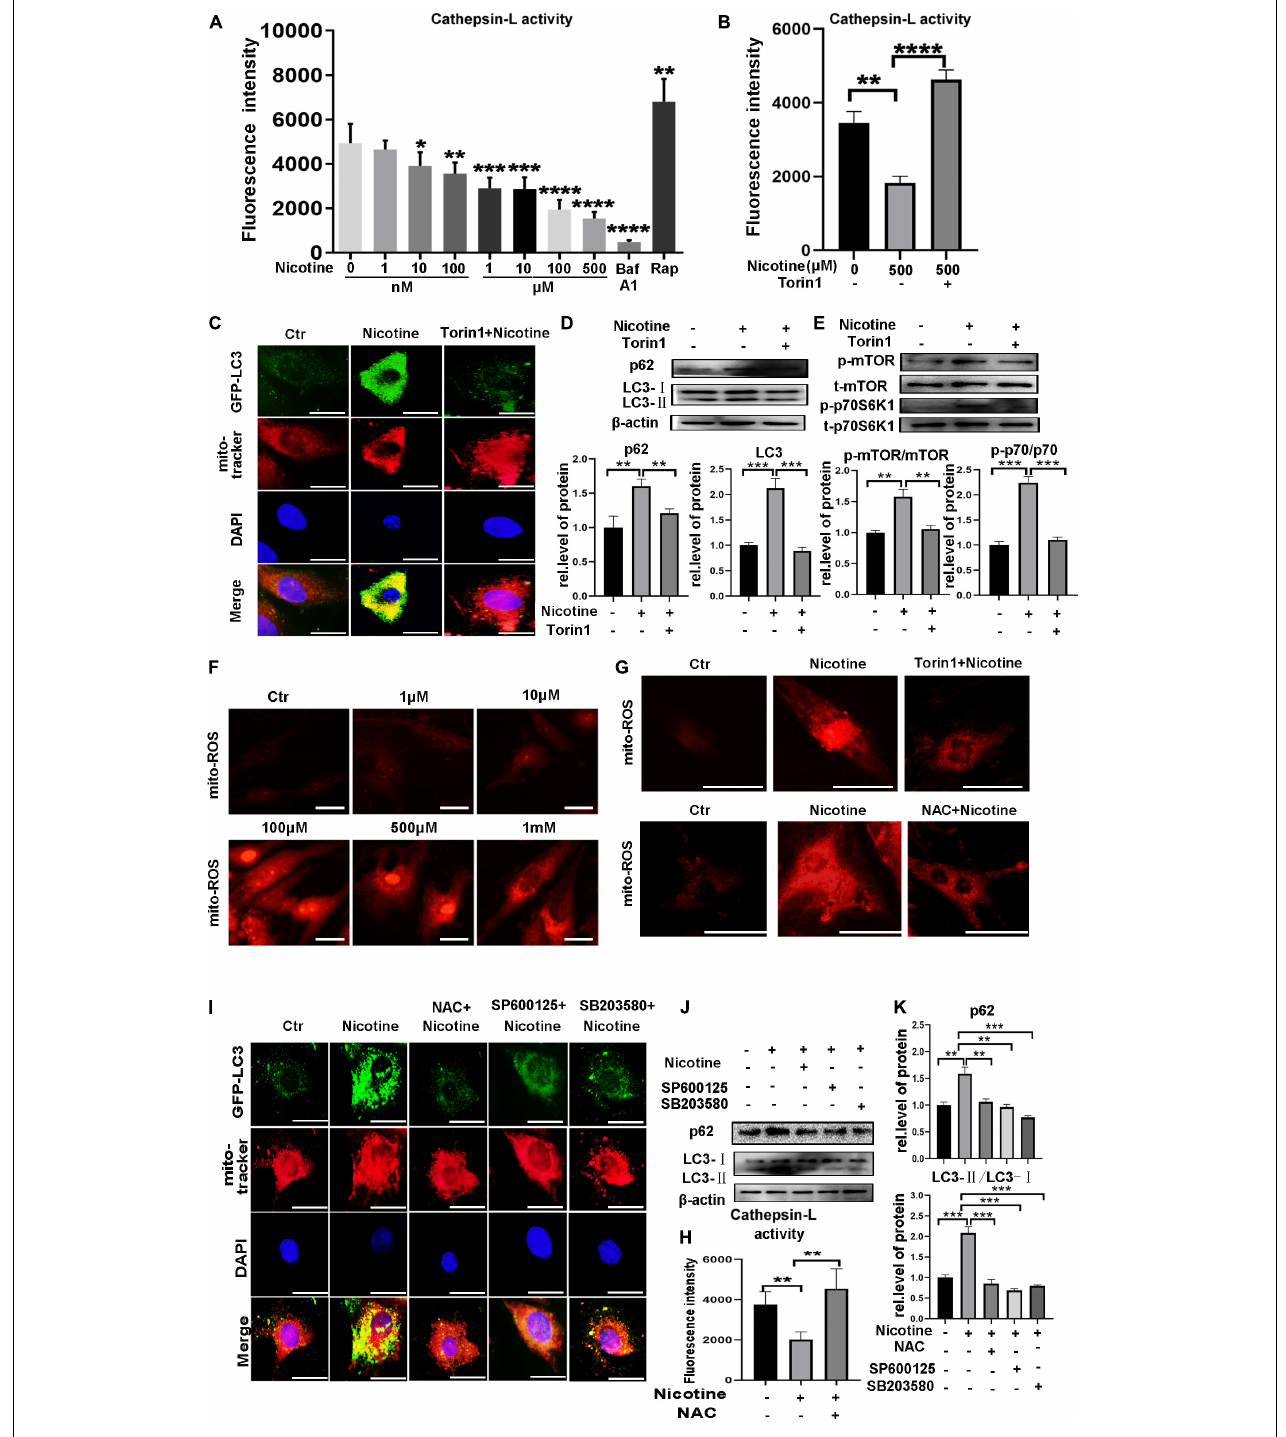
FIGURE 3 | Nicotine caused mitophagy impairment through decreased the CTSL enzyme activity via ROS mediated p38/JNK pathway. (A) Nicotine decreased the activity of CTSL. (B) Torin1 alleviated the activity of CTSL damaged by nicotine. (C) Immunofluorescence co-localization analysis was used to detect the effect of Torin1 after nicotine treatment. Representative of n = 3 experiments. (Scale bar = 20 µ m). (D) Western blotting was used to detect the expression of p62 and LC3. (E) Western blotting was used to detect the activation of mTOR pathway . (F,G) Mito-ROS was detected by mito-SOX (Scale bar = 20 µ m). (H) CTSL activity was restored with NAC pretreatment (I) Mitophagic flux impairment was rescued by NAC, SP100625 and SB203580. Representative of n = 3 experiments. (Scale bar = 20 µ m). (J) Western blotting was used to detect the expression of p62 and LC3. (K) Image J was used to quantification (**** p < 0.0001. *** p < 0.001. ** p < 0.01. * p < 0.05, n =